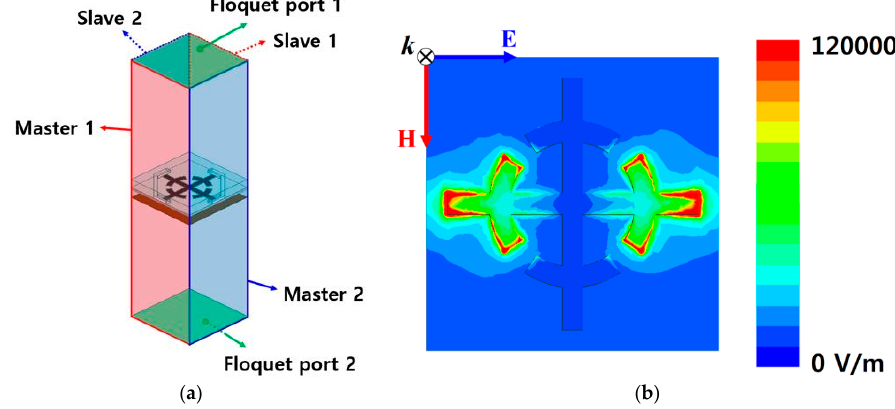
Figure 3. ( a ) Simulation setup for boundary conditions and excitations; ( b ) Magnitude of the electric field distribution of the proposed metasurface without a microfluidic channel.